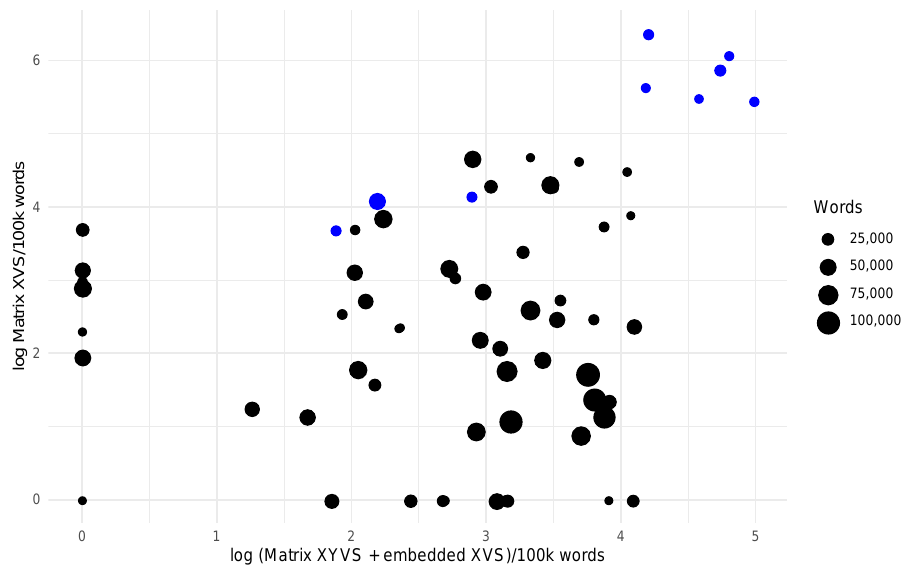
Figure 4. Frequency of the CM orders, and of matrix XVS orders with pronominal subjects, in Old and Middle English texts of > 10,000 words length. Major northern texts are highlighted in blue. However, the Ormulum and Richard Rolle’s works have a different profile (these are the other blue dots in Figure 4). Examples of the CM orders from these texts, while not nonexistent, are rare. (32) gives two examples of embedded XVS order, the more common of the two CM orders in these